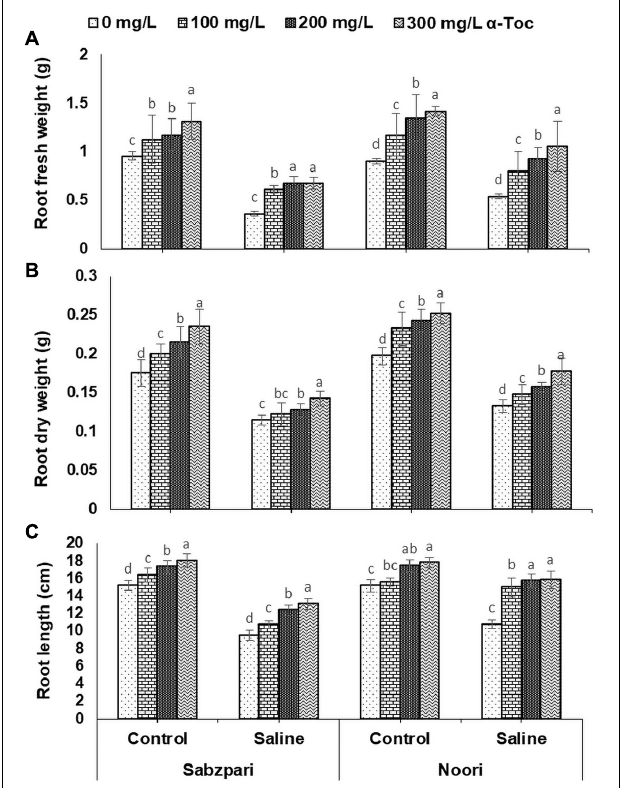
FIGURE 1 | Root fresh weight (A) , Root dry weight (B) , Root length (C) of okra varieties sprayed with different levels of α -tocopherol under saline conditions. Values represent means ± S.D. Significant differences among row spacing were measured by the least significant difference (LSD) at p > 0.05 and indicated by different letters.